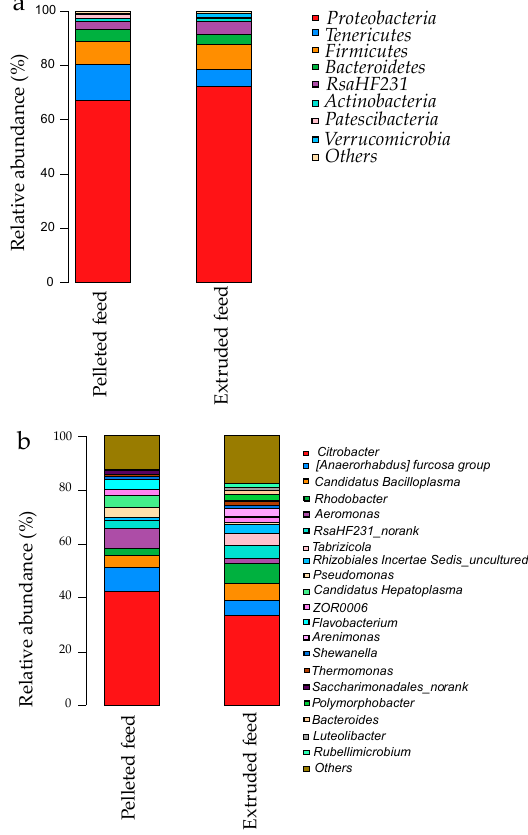
Figure 3. Relative abundances of the dominant bacteria at the ( a ) phylum level and ( b ) genus level in P. clarkii fed pelleted feed and extruded feed.